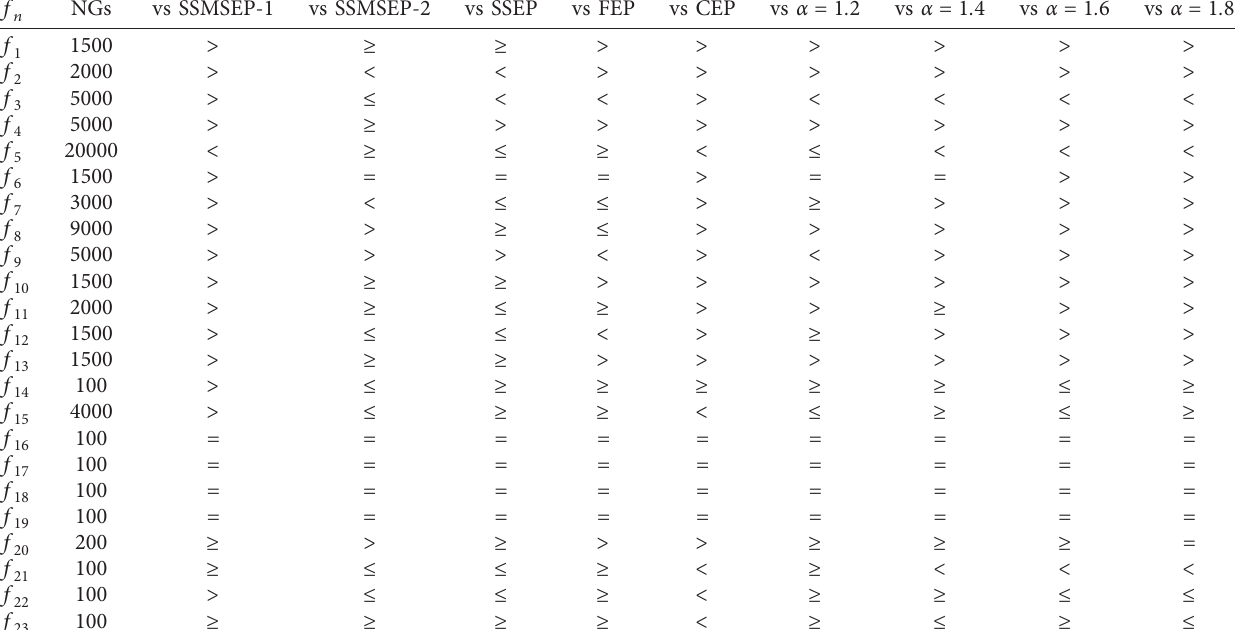
Table 5: 2-tailed Wilcoxon signed-rank test for SSMSEP vs SSMSEP-1, SSMSEP-2, SSEP, FEP, CEP, and LEP with α � ( 1 . 2 , 1 . 4 , 1 . 6 , 1 . 8 ) on f − f (NGs: number of generations). 1 10